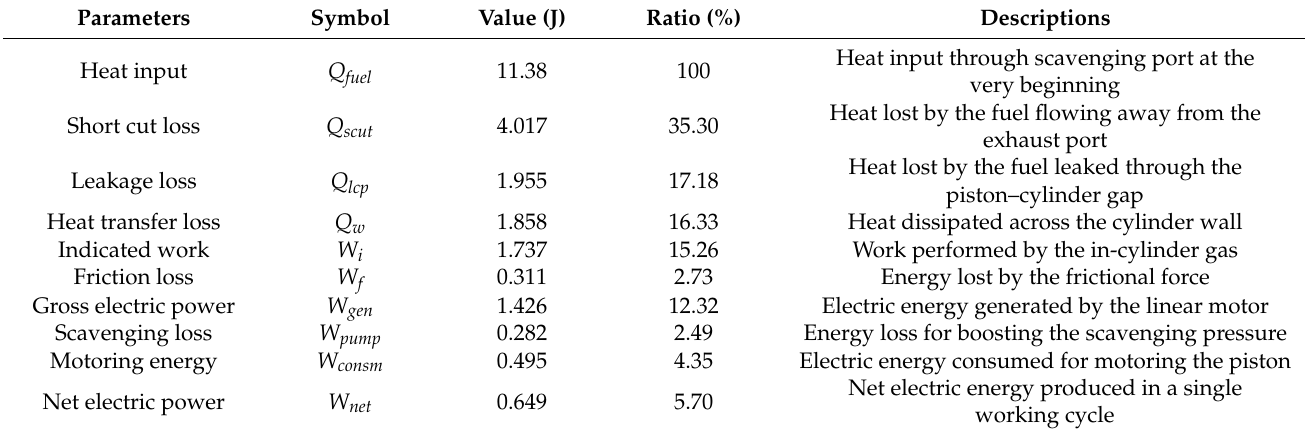
Table 3. Energy flow distribution per cycle in the MFPG